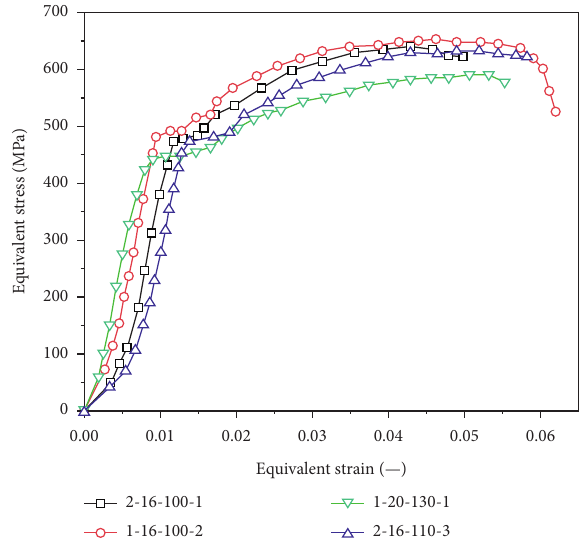
Figure 1: The stress-strain curves of the grouted